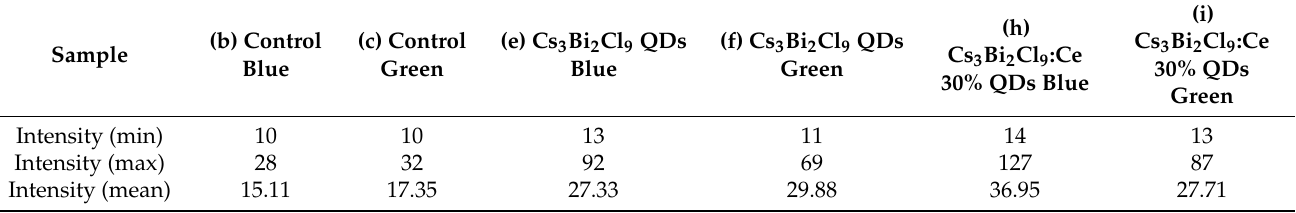
Table 7. Upconversion fluorescence intensity of quantum dots in the